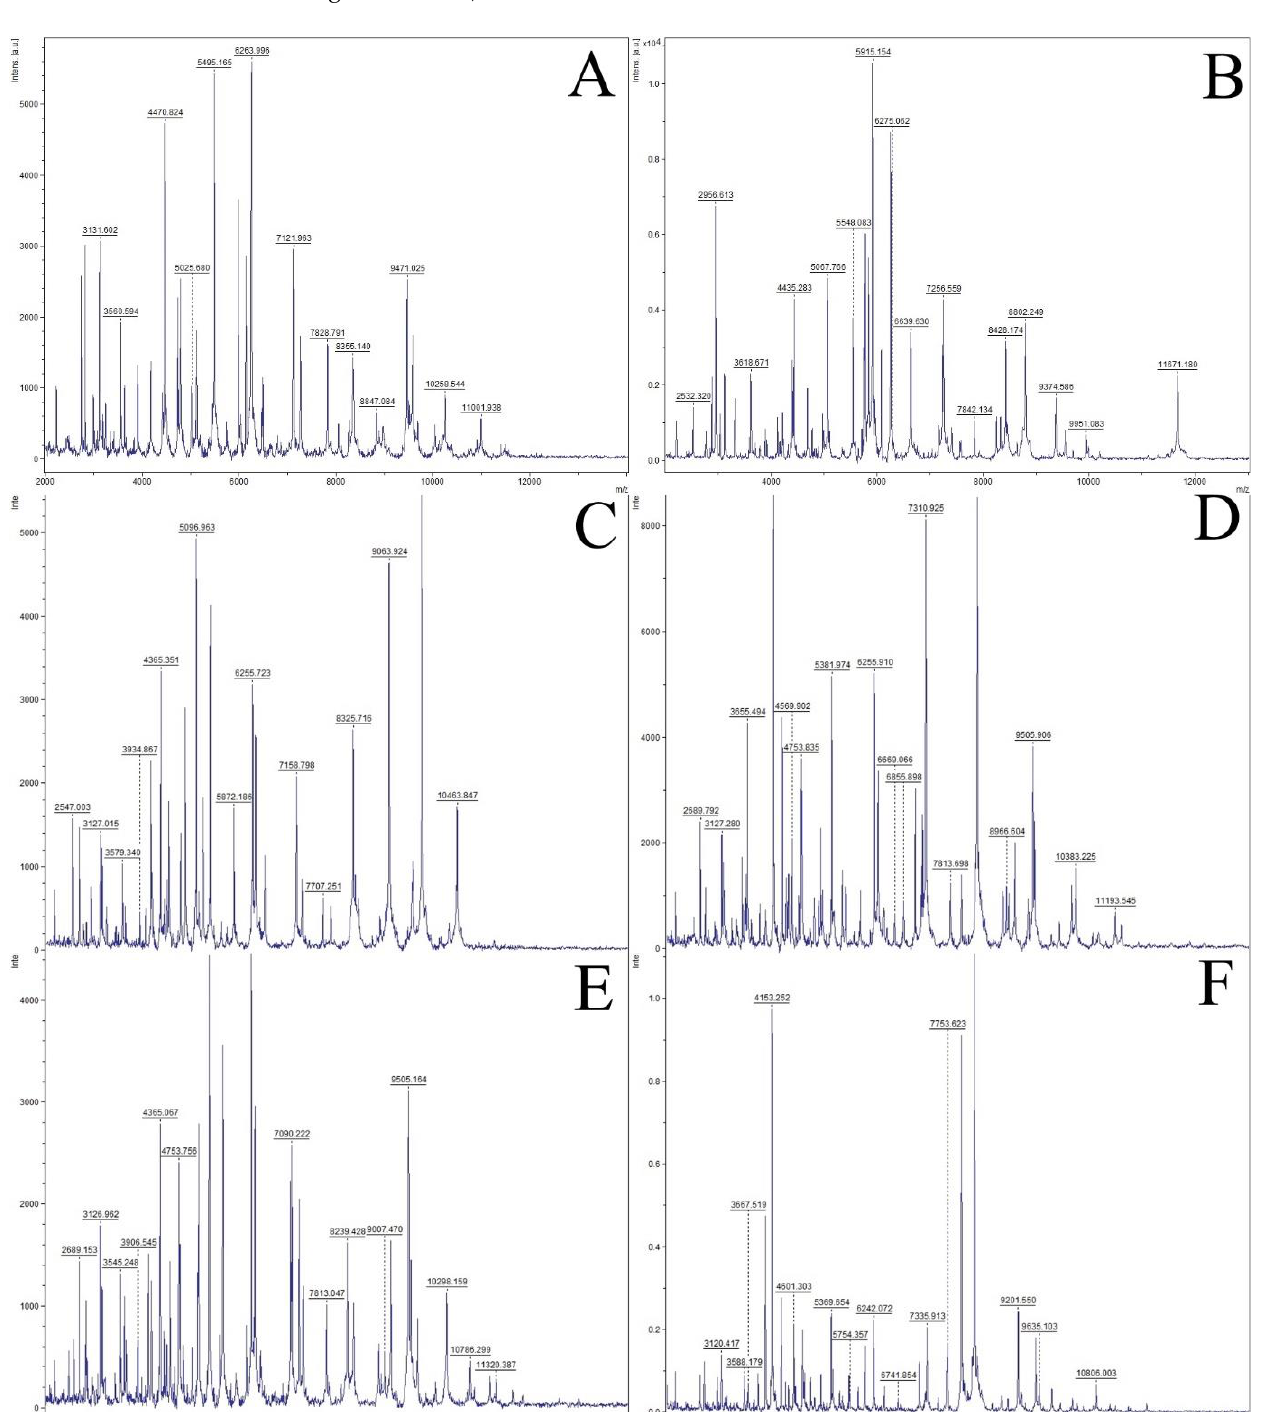
Figure 2. Mass spectra of the isolated bacteria ( A ) — P. mirabilis ; ( B ) — Pseudomonas spp.; ( C ) — E. coli; ( D ) — E. cloacae ; ( E ) — E. asburiae ; ( F ) — R. aquatilis ).